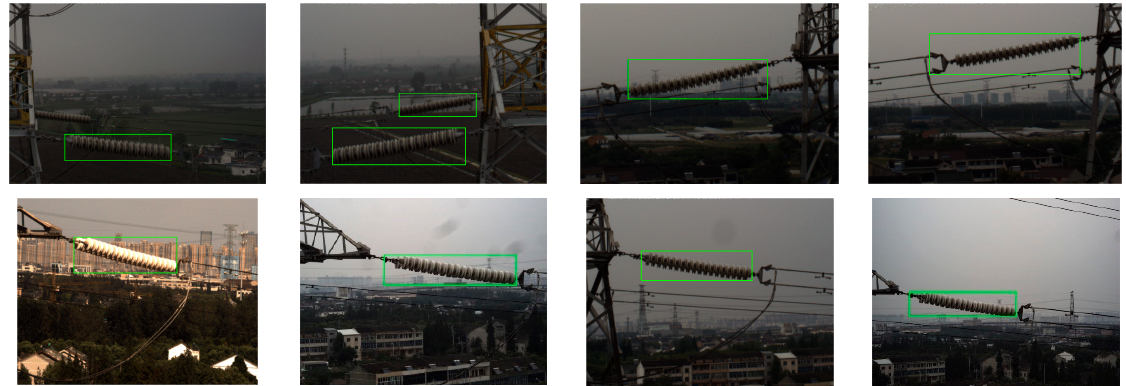
Figure 11. Detection examples of insulators in complex backgrounds.